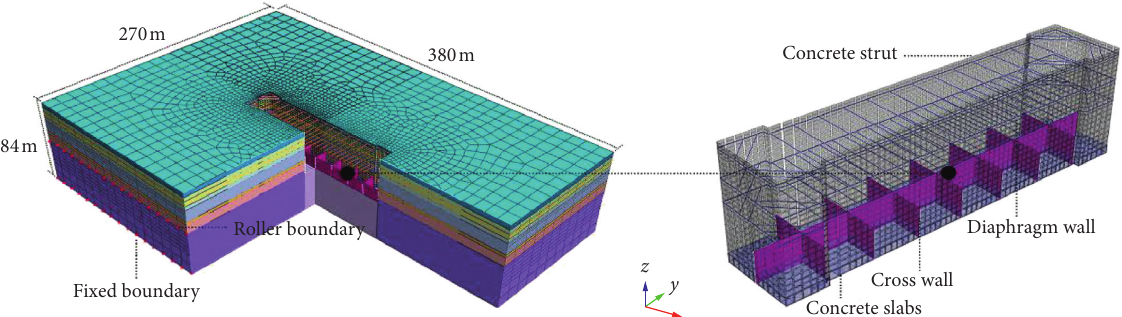
Figure 14: Three-dimensional finite element mesh for